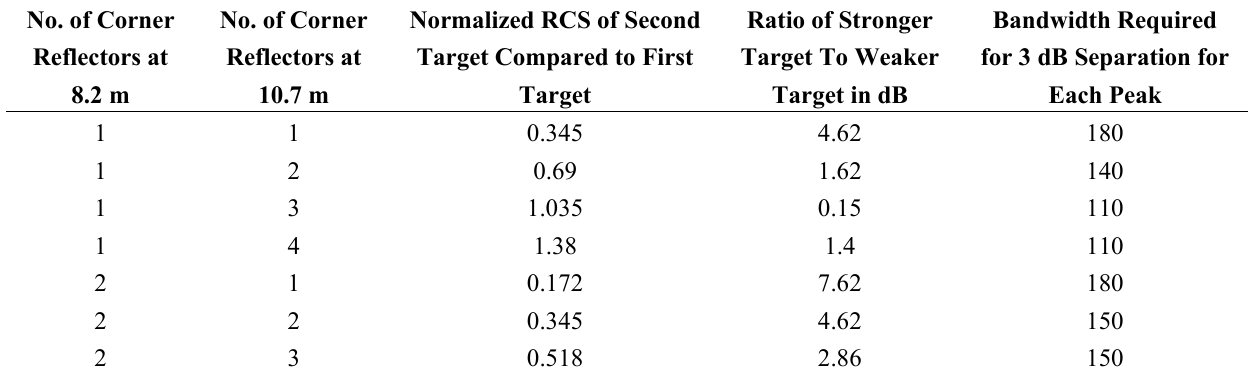
Table 10. Field results for Scenario WITH varying relative RCS